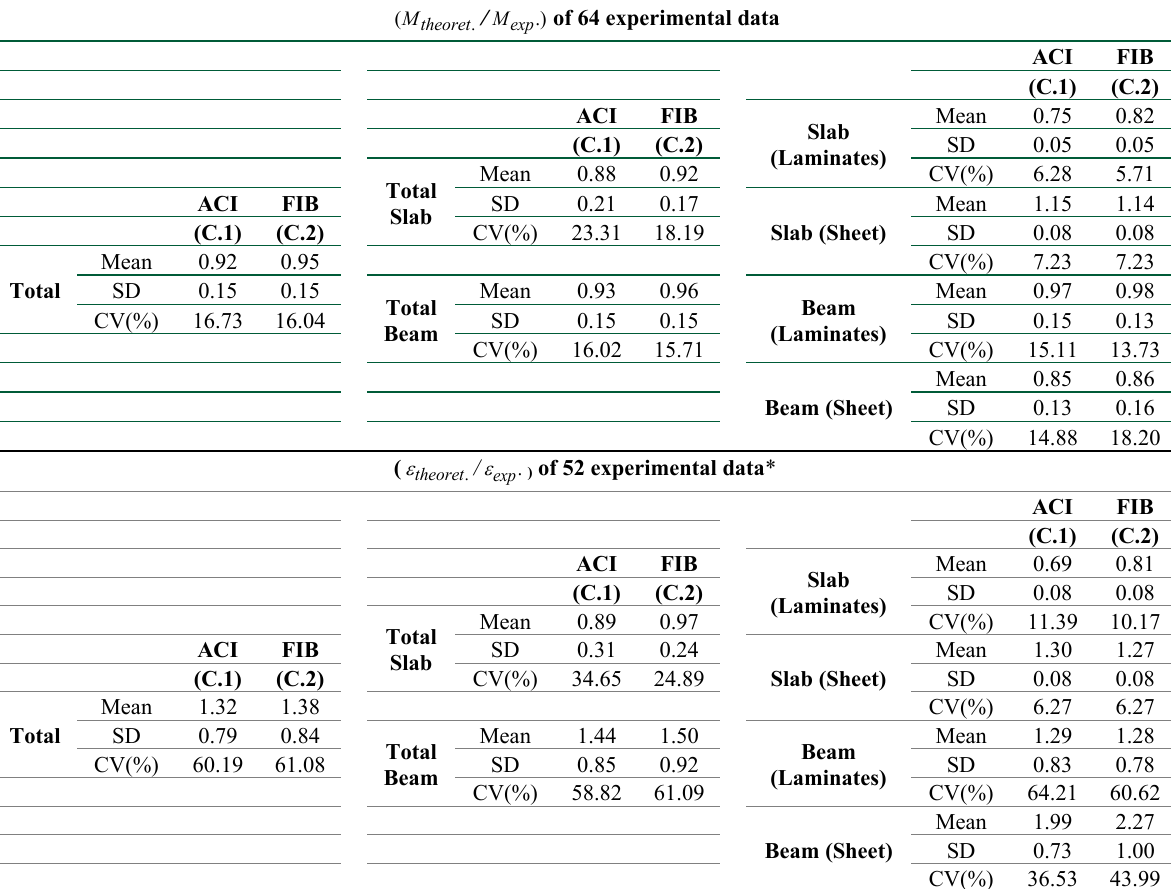
Table 4. Mean, standard deviation (SD), and coefficient of variation (CV) of the ratios ( theoretical M / ) exp M and ( theoretical  / ) exp  - FIB x